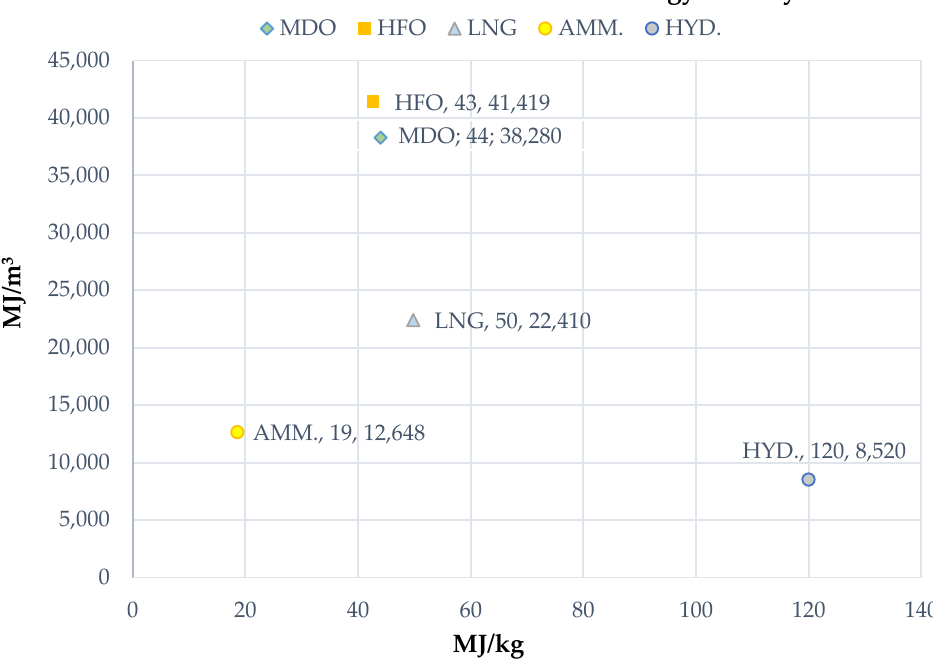
Figure 1. Comparison between fuels in terms of LCV and volumetric energy density.